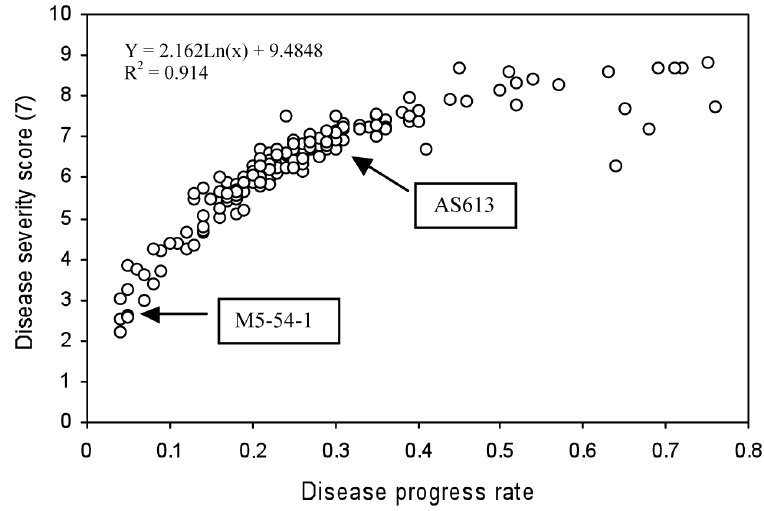
Figure 1. Correlation between the disease severity scores seven days after inoculation and the disease progress rate for 184 sunflower genotypes inoculated with Phoma macdonaldii isolate MP6 in controlled conditions. Arrows show the resistant mutant line M5-54-1 and the original line